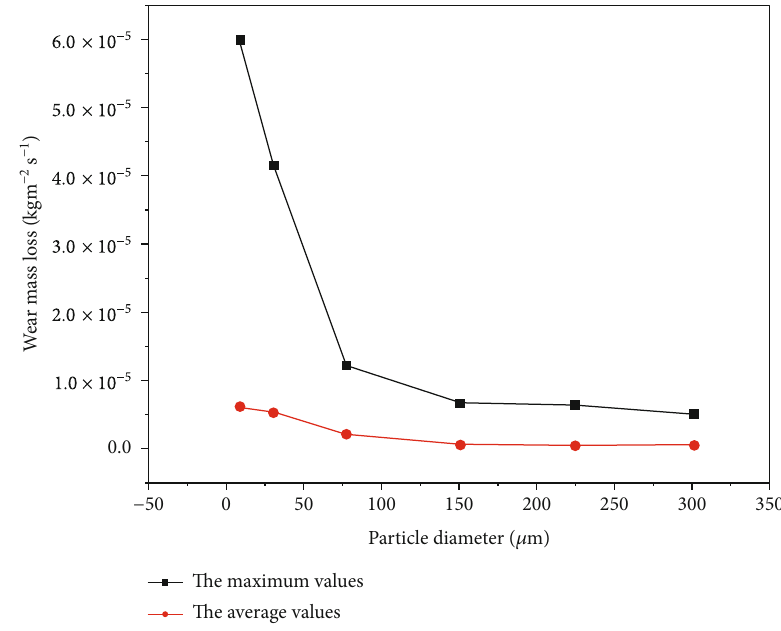
Figure 10: Variation of wear mass loss of volute material with the particle diameter.